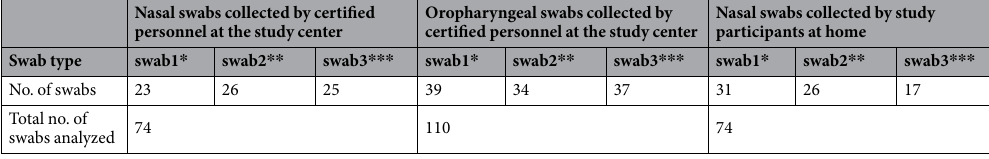
Table 3. Overview of swabs included in the microbiome analysis. 313 samples originating from 258 individuals were analyzed. To avoid possible bias, a subset of analyses was performed on 258 samples comprising only one swab per individual. * Swab 1 – flocked nylon swab. ** Swab 2 – rayon swab. *** Swab 3 – polyurethane tipped swab. Swab 4 (calcium alginate) was excluded because it had proven unsuitable during preanalytical processing (see